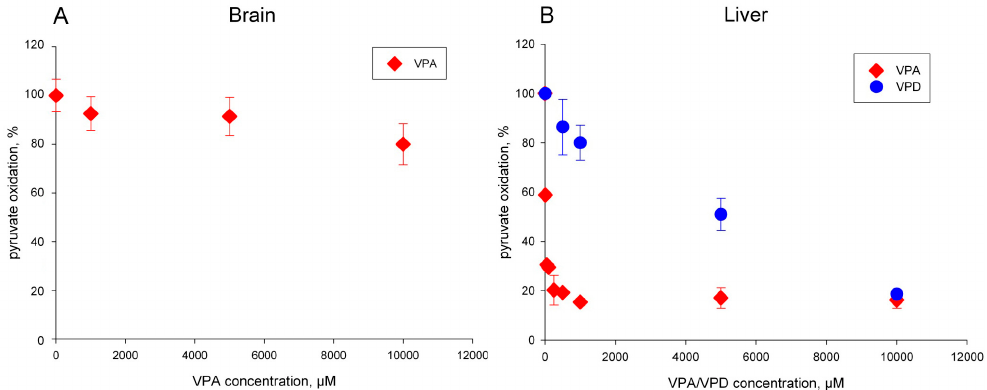
Figure 2. Inhibition of mitochondrial pyruvate oxidation by valproic acid in rat brain mitochondria ( A ) and rat liver mitochondria ( B ). Mitochondria (0.04–0.05 mg protein/mL for brain or 0.2 mg/mL protein/mL for liver) were preincubated for 3 min in presence of 1 mM ATP, 5 mM MgCl 2 with the indicated amount of VPA. The maximal rate of respiration was determined in presence of 10 mM pyruvate, 5 mM malate, and 1 mM ADP. The plotted rates are averages of three independent experiments. VPD